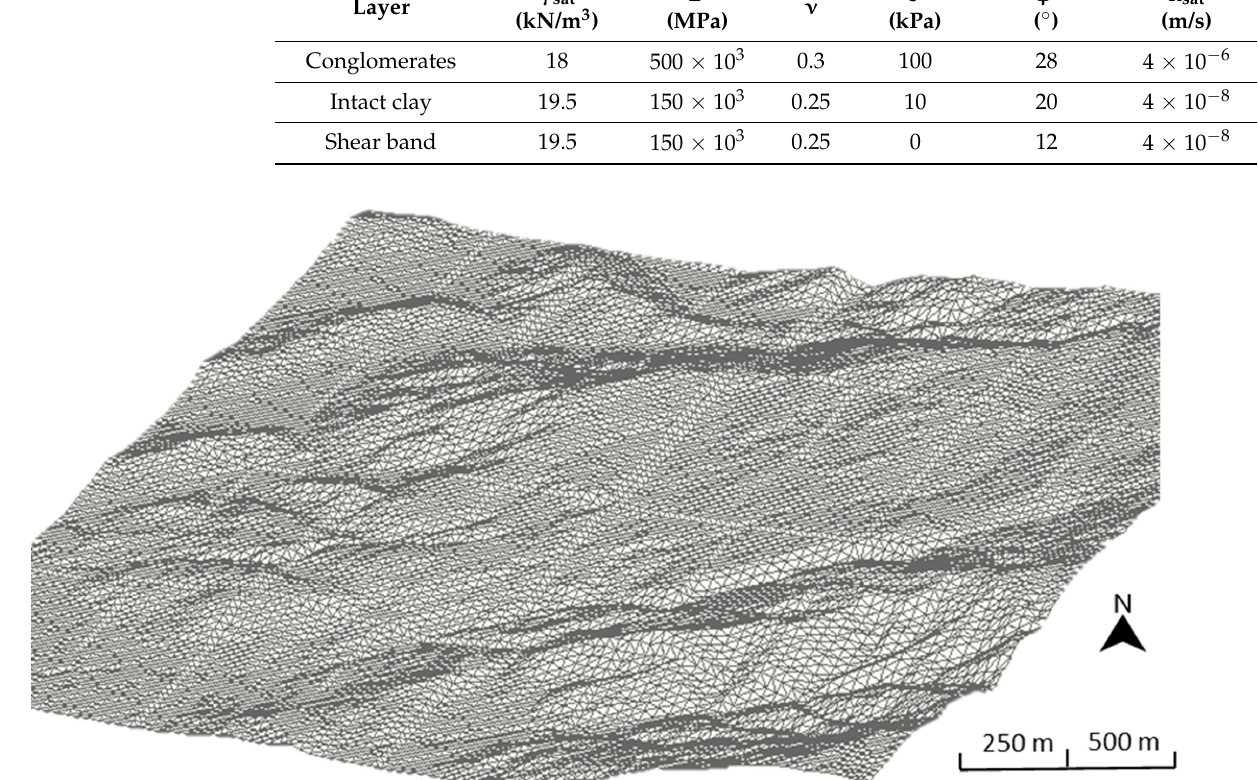
Table 2. Soil hydraulic and mechanical parameters adopted in the stress–strain FEM analyses. Layer